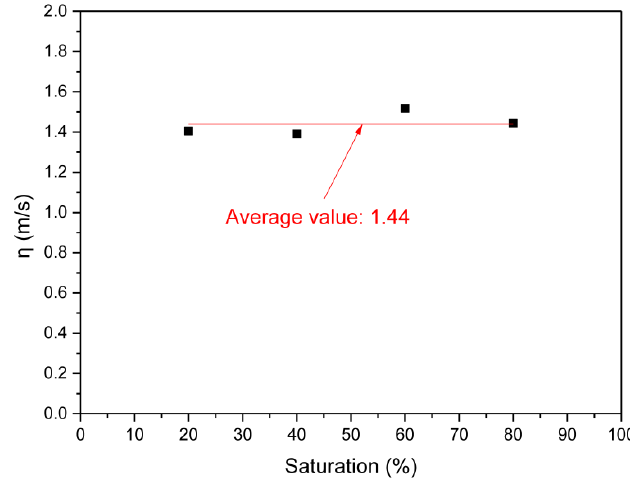
Figure 6. The relationship between the characteristic velocity η and the NGH saturation.